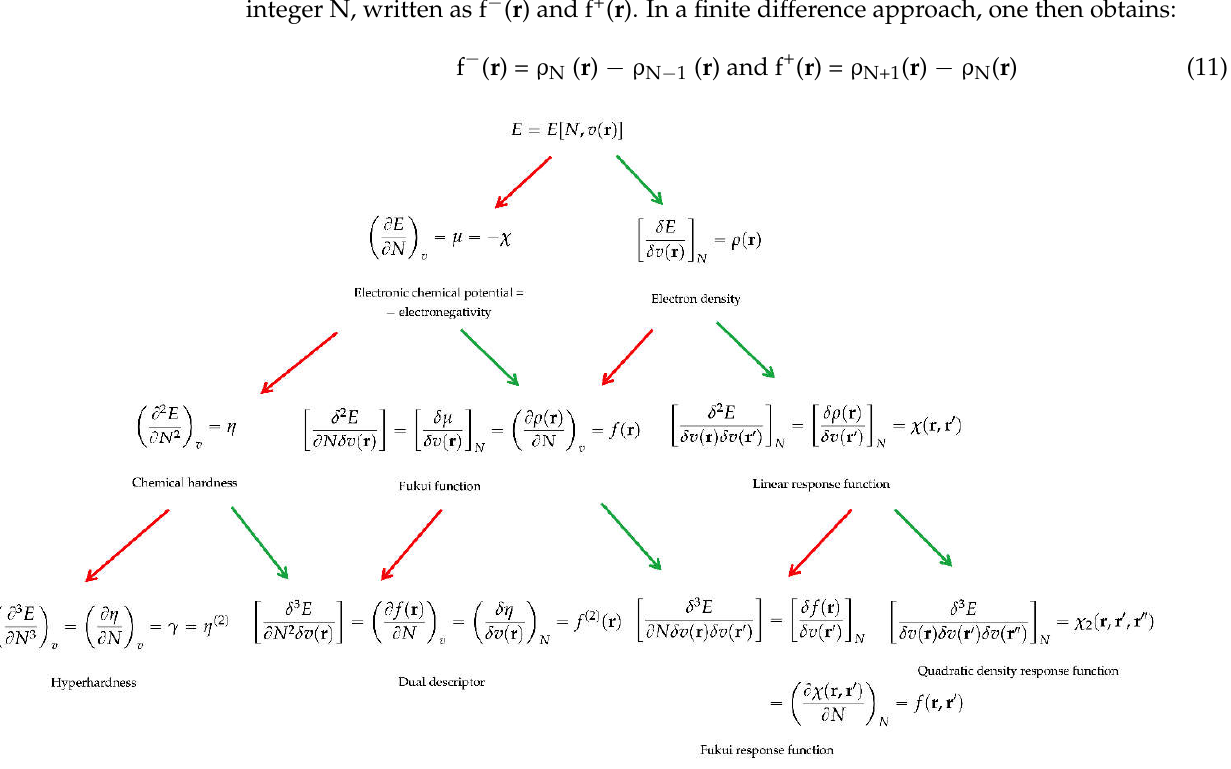
Figure 1. Response function tree of the energy E vs. changes in the number of electrons N and the external potential v( r ). Red arrows indicate differentiation with respect to N, and green arrows indicate differentiation with respect to v( r ). Reprinted with permission, from Conceptual Density Func-